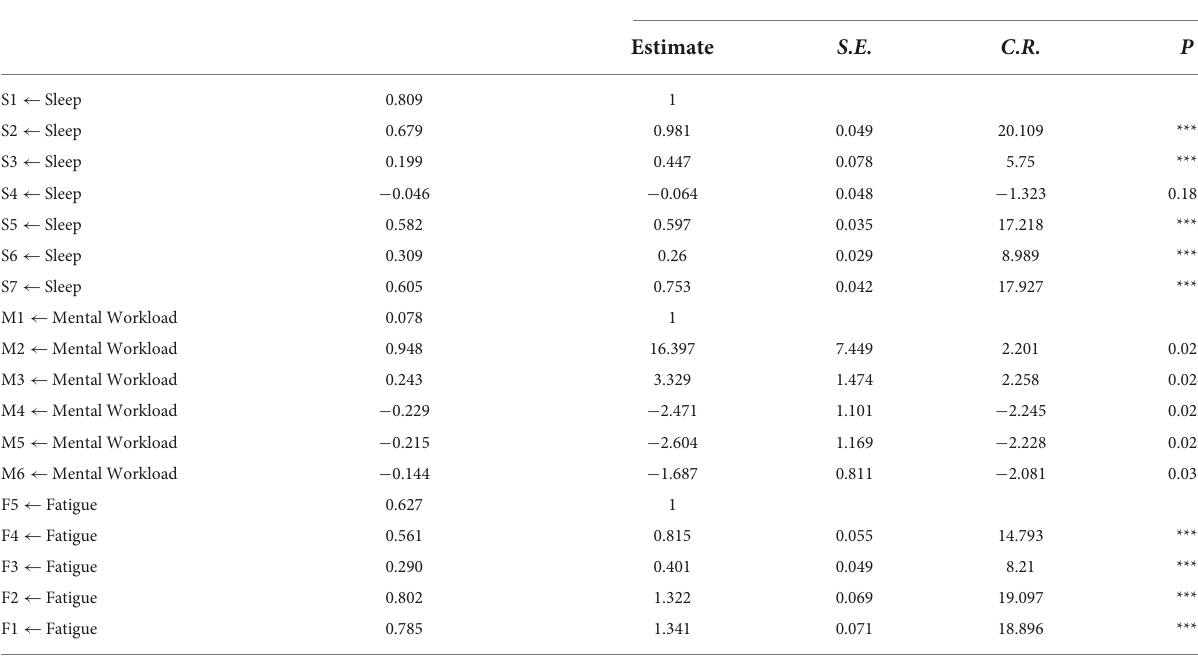
TABLE 2 Path coefficients, unstandardized regression coefficients and their significance ( n =